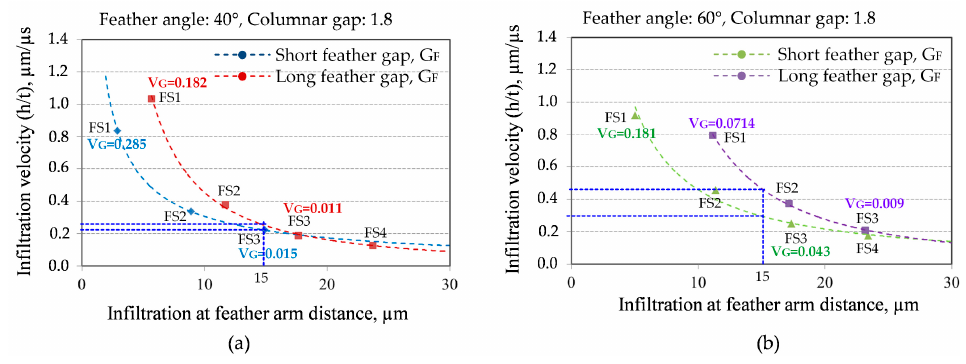
Figure 17. Lateral (sideway) infiltration in feather gaps showing velocity reduction in feather arm sets (FS) and the change of velocity gradient: ( a ) Comparison for 40° inclined feathers; ( b ) comparison for 60° inclined feathers.